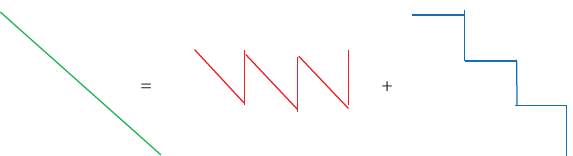
Figure 3: In a crystal, (a) the linear external electric potential can be broken into (b) its periodic saw-tooth component and (c) its nonperiodic staircase-like